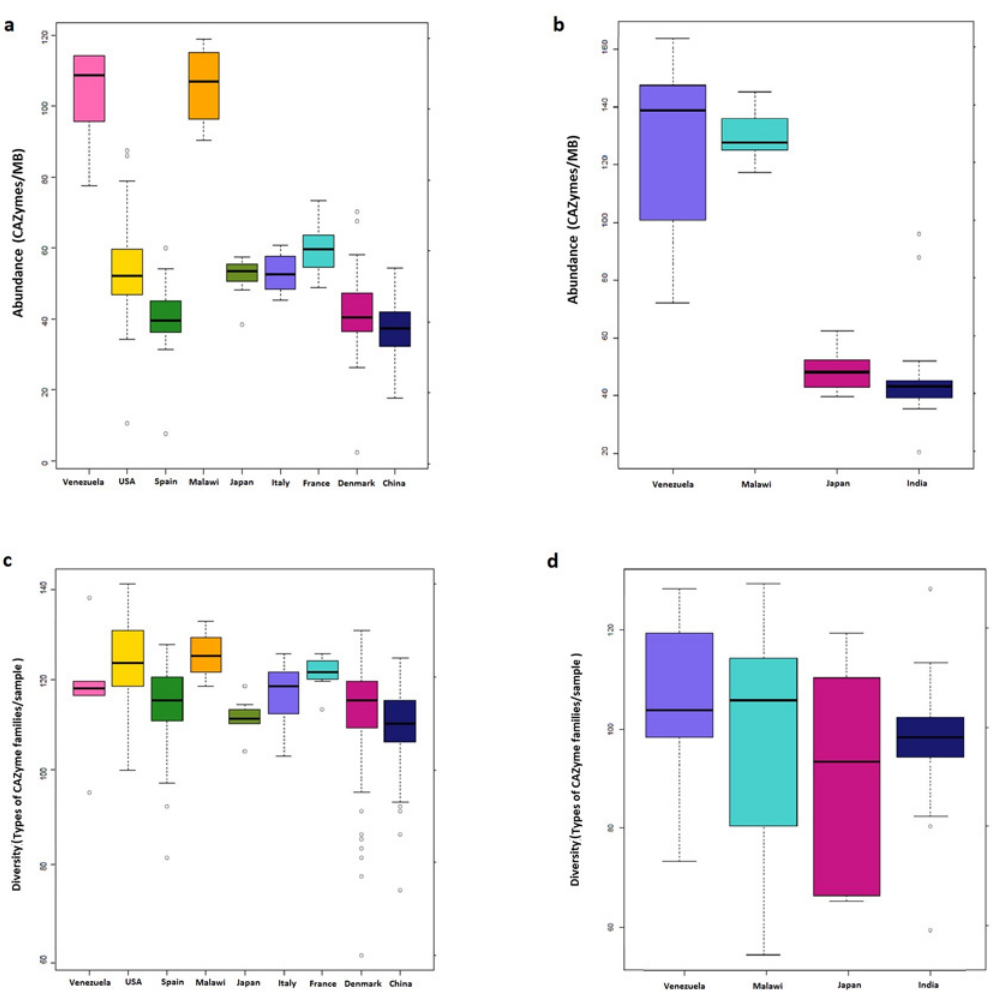
Fig 5. Variation of the abundance and diversity of CAZymes across geographies. Variation of the abundance of CAZymes across (a) Adult individuals belonging to various geographies and, (b) Children/infant individuals belonging to four geographies. Variation of the diversity of CAZymes across (c) Adult individuals belonging to various geographies and, (d) Children/infant individuals belonging to four geographies. For the adult individuals, while there is little variation in the diversity of CAZymes across countries, there are country-specific trends in the abundances of various CAZyme families. High CAZyme/MB content in individuals from rural Venezuela and Malawi may be attributable to their carbohydrate rich diet. It also shows that each adult individual, in general, have a consistent diversity across countries. However, in children and infants, in whom the gut flora is developing and unstable, diversity of CAZymes fluctuates